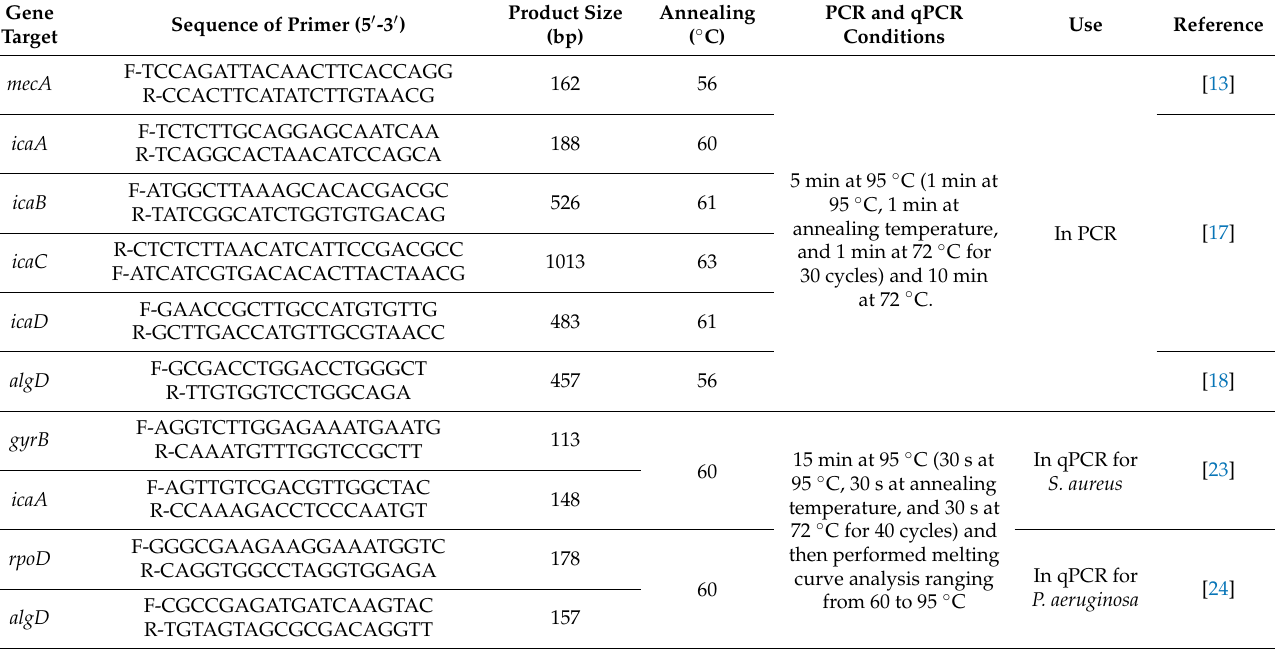
Table 1. PCR primer sequences and PCR condition for mecA and ica genes in this study. Gene